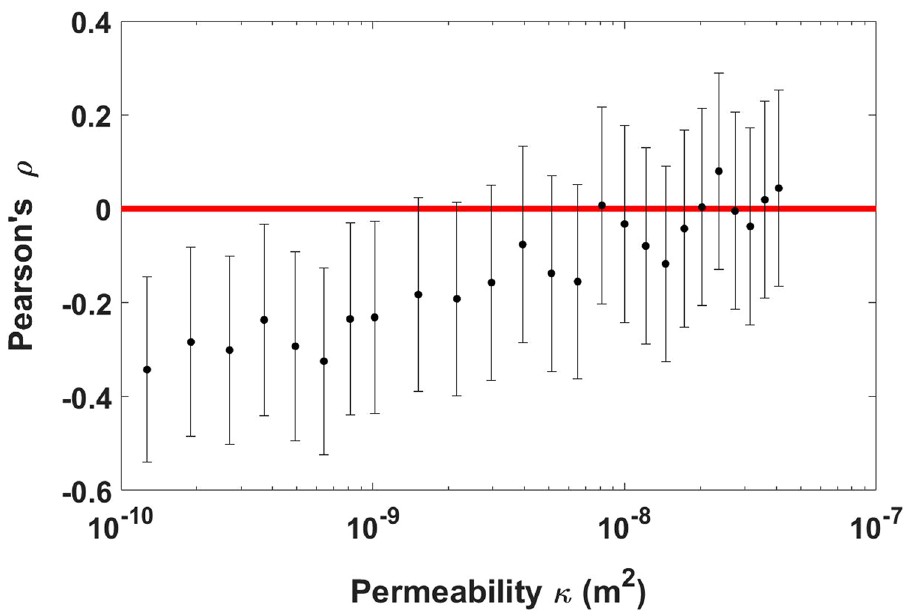
Figure 4. Pearson coefficient ( ρ ) between lunar cycles and the modelled seismic amplitude for different values of the cap permeability ( κ ). Error bars represent four standard deviations of uncertainty (4-sigma confidence level). We use phase shift δ = π (similar results are obtained with π /2 < δ < 3 π /2; see Supplementary Discussion and Supplementary Fig. S13) and realistic values for the different parameters of the model 35,36 (see details in Methods, Section 3); these values allow generating tremor signals with dominant frequency around 2 Hz (Supplementary Fig. S9), as observed on Ruapehu 37